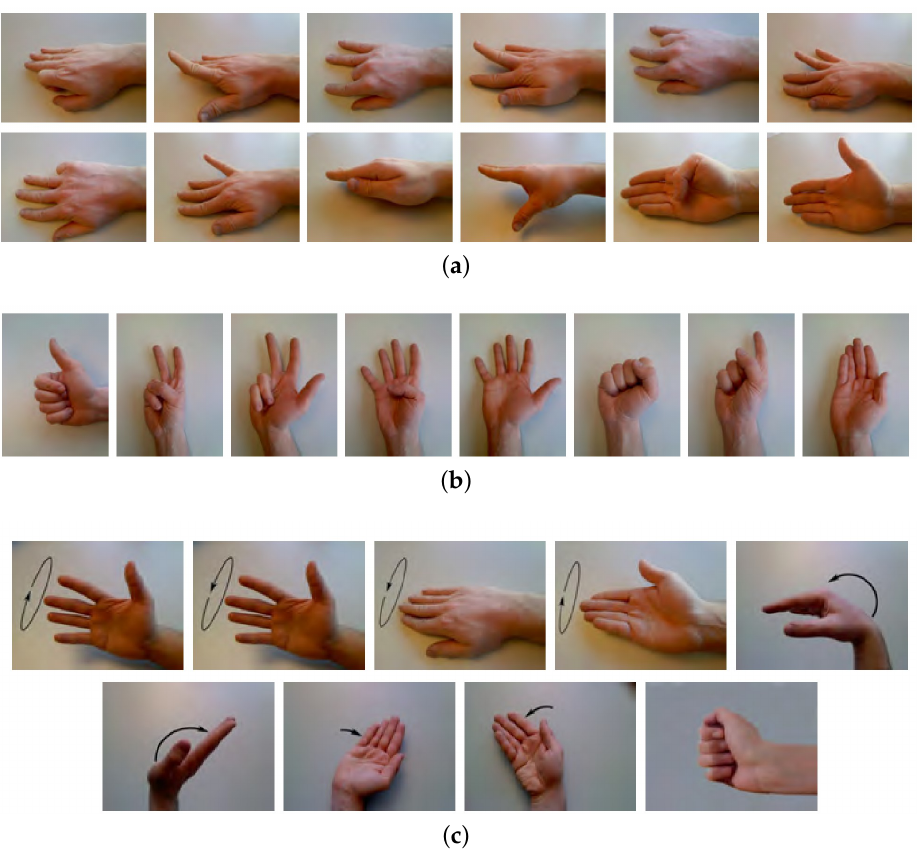
Figure 5. Finger and wrist gesture categories in CapgMyo [19] and NinaPro DB1 [20]. ( a ) Twelve basic movements of finger in DB-c and Exercise A; ( b ) eight isometric and isotonic hand configurations in DB-a and Exercise B; and ( c ) nine basic movements of the wrist in Exercise